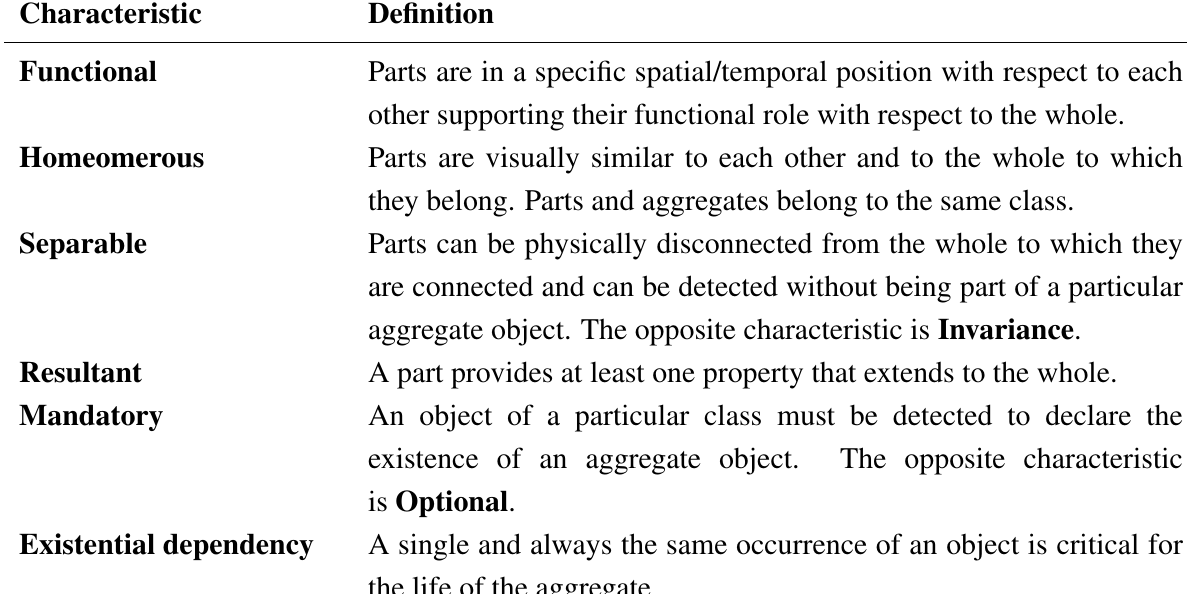
Table 1. Set of characteristics to classify part-whole